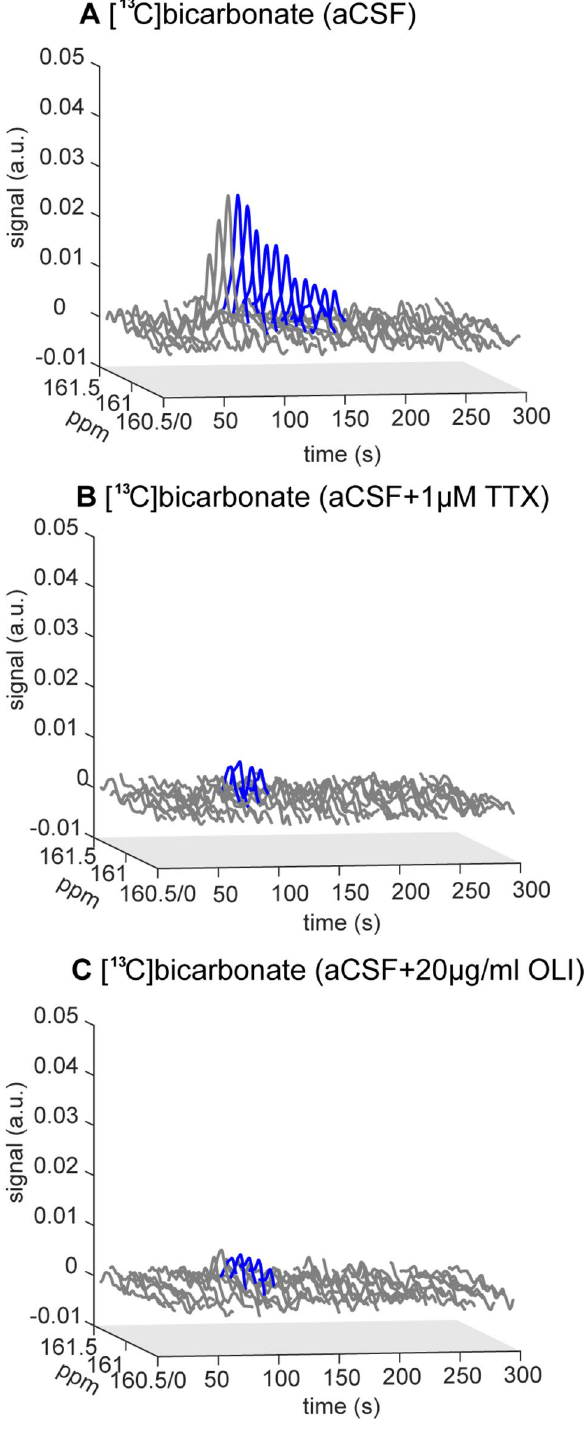
Figure 3. Typical hyperpolarized [ 13 C]bicarbonate signal over time, acquired after incubations with aCSF (control), TTX, and OLI. ( A ) Incubation with aCSF (control). ( B ) Incubation with 1 µM TTX. ( C ) Incubation with 20 µg/ml OLI. The part of the spectrum shown in blue color is the [ 13 C]bicarbonate signal used for the analysis of [ 13 C]bicarbonate production ( i.e. with sufficient SNR and under a constant [1- 13 C]pyruvate concentration). The relative intensities of these signals may be better appreciated with a collapsed time axis presented in Fig. S1 (Supporting